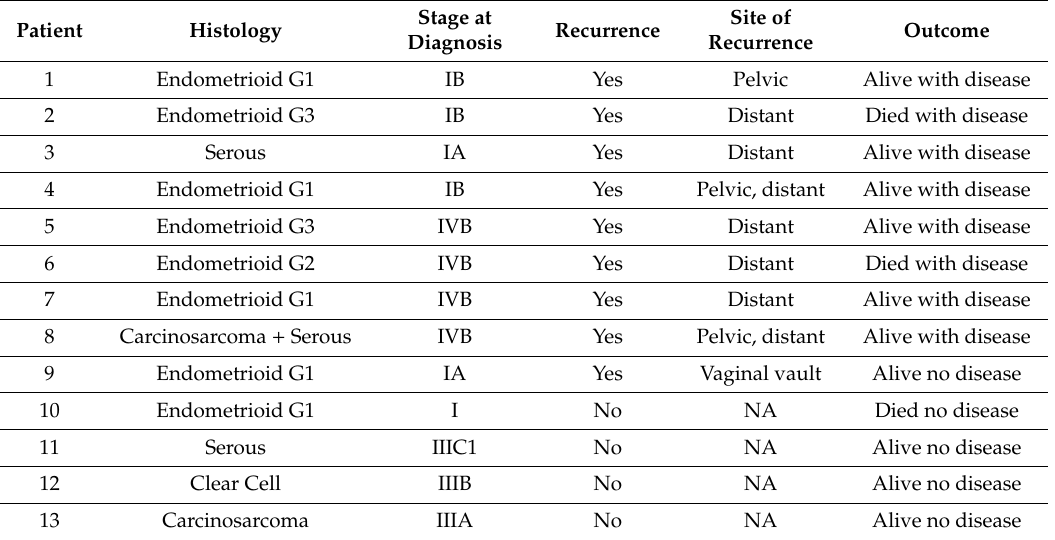
Table 1. Tumor characteristics and outcome of study cohort ( n =